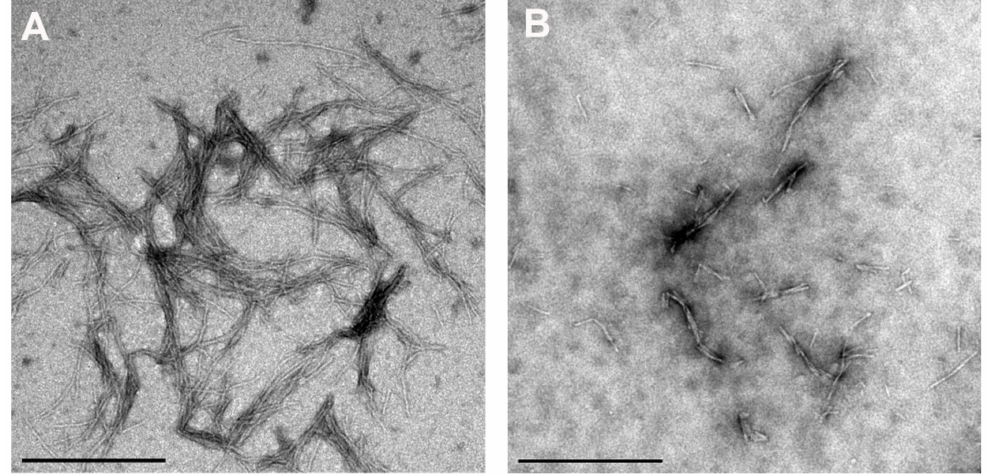
Figure 4. TEM images of stB fibrils at the plateau phase ( A ) alone or ( B ) at 100 µ M Res + 0.5 mM vitC. Scale bars = 0.5 µ